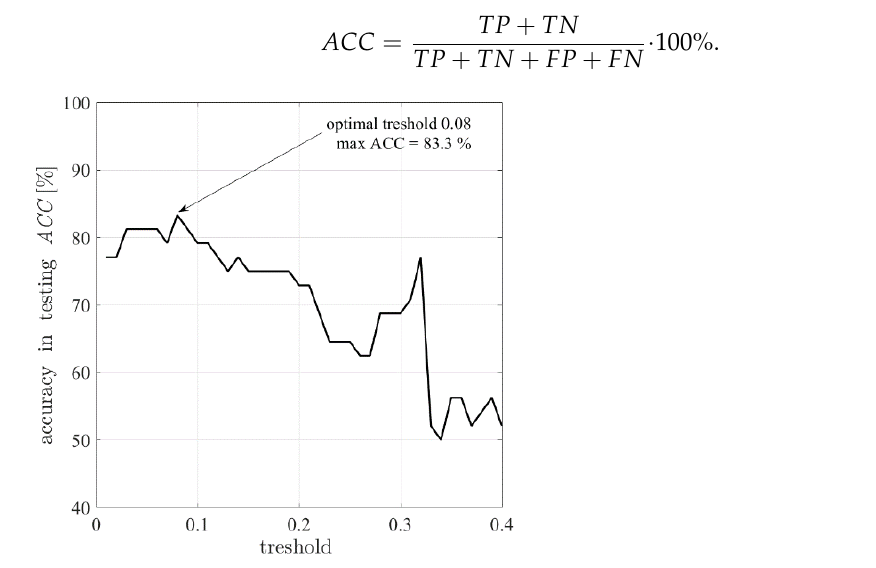
Figure 4. Accuracy of the recognition obtained in the test set as a function of the threshold value.